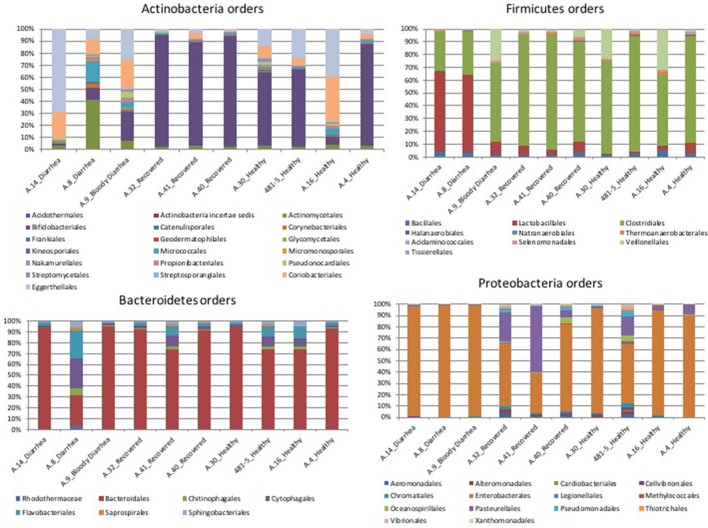
Distribution of the OTUs in the metagenomes from the STEC O26 outbreak, obtained through the analysis based on read mapping. The scale on the y axis refers to the percentage of the reads mapping to the specific OTU.